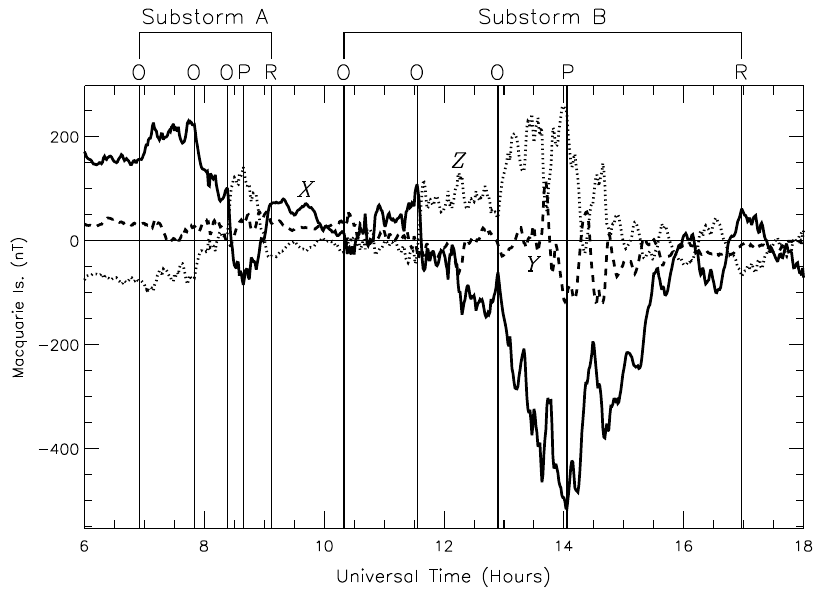
Fig. 1. Perturbations of the geomagnetic X (solid curve), Y (dashed curve), and Z (dotted curve) components measured by the MQI magnetometer during 06:00 to 18:00 UT on 30 November 2002. Annotations indicate approximate times of substorm onset (O), peak expansion (P), and end of recovery phase (R). The abscissa has tick marks at 30-min intervals of